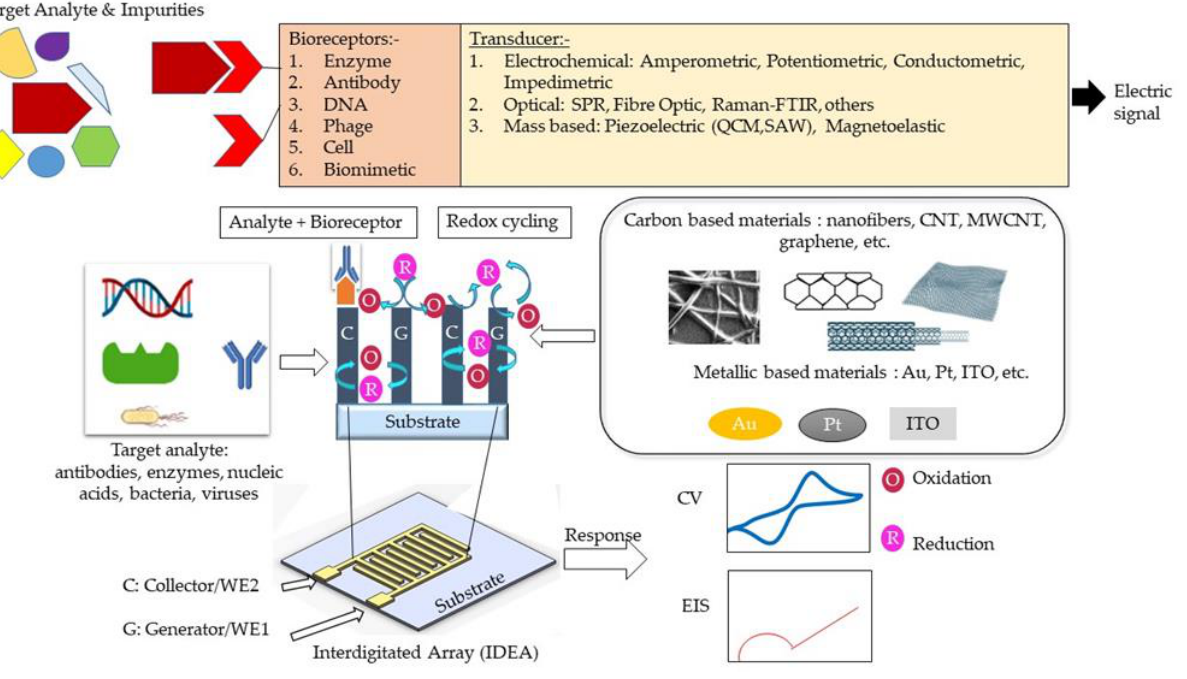
Figure 1. Schematic design of IDEA design-based electrochemical detection (amperometric and impedimetric) methods.